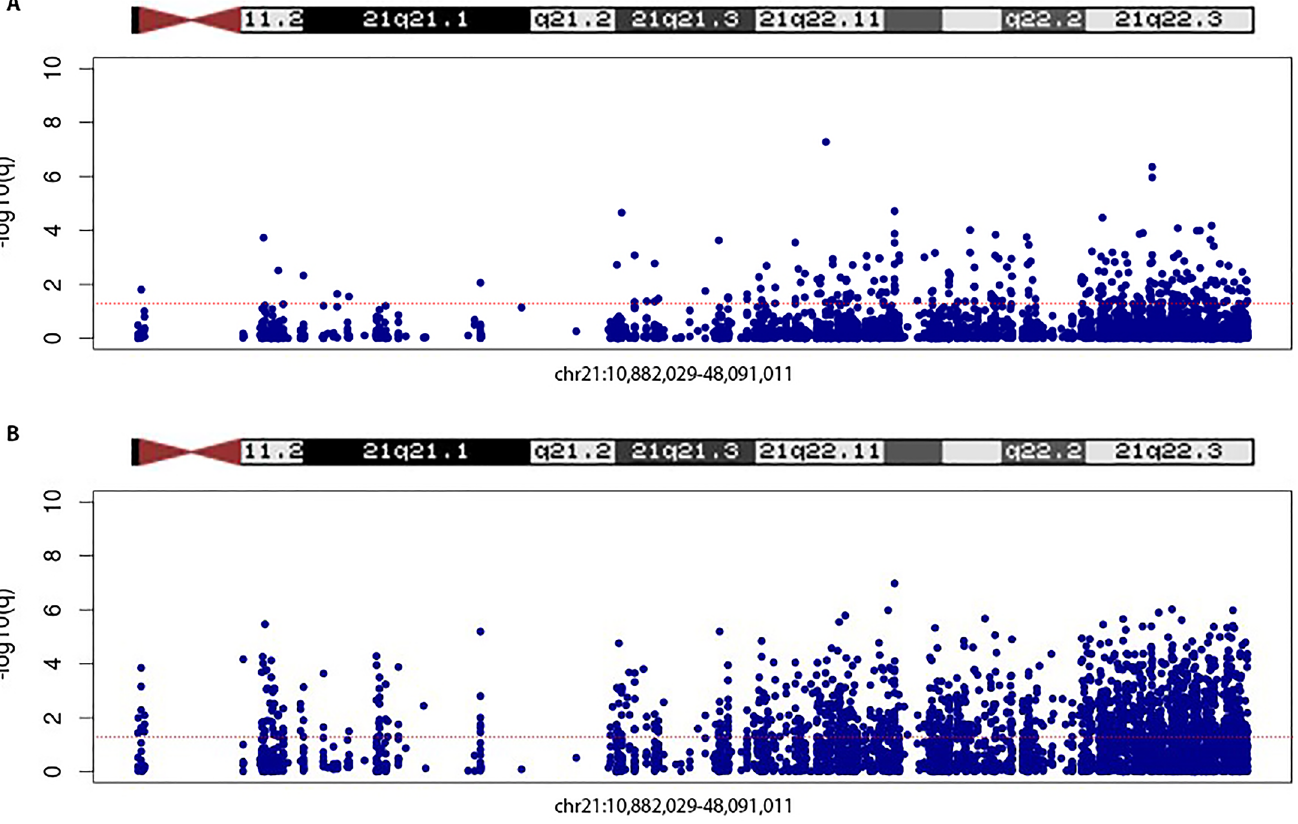
Fig 5. Chromosome 21 Manhattan plots. (A) Manhattan plot chromosome 21 only, DMP association analysis, corrected for gender. X-axis represents ranked position chromosome 21, Y-axis represents q-value DMPs. Red line indicates significance level (q < 0,05). (B) Manhattan plot chromosome 21 only, DMP association analysis, corrected for gender and blood cell distribution. X-axis represents ranked position chromosome 21, Y-axis represents q-value DMPs. Red line indicates significance level (q < 0,05).